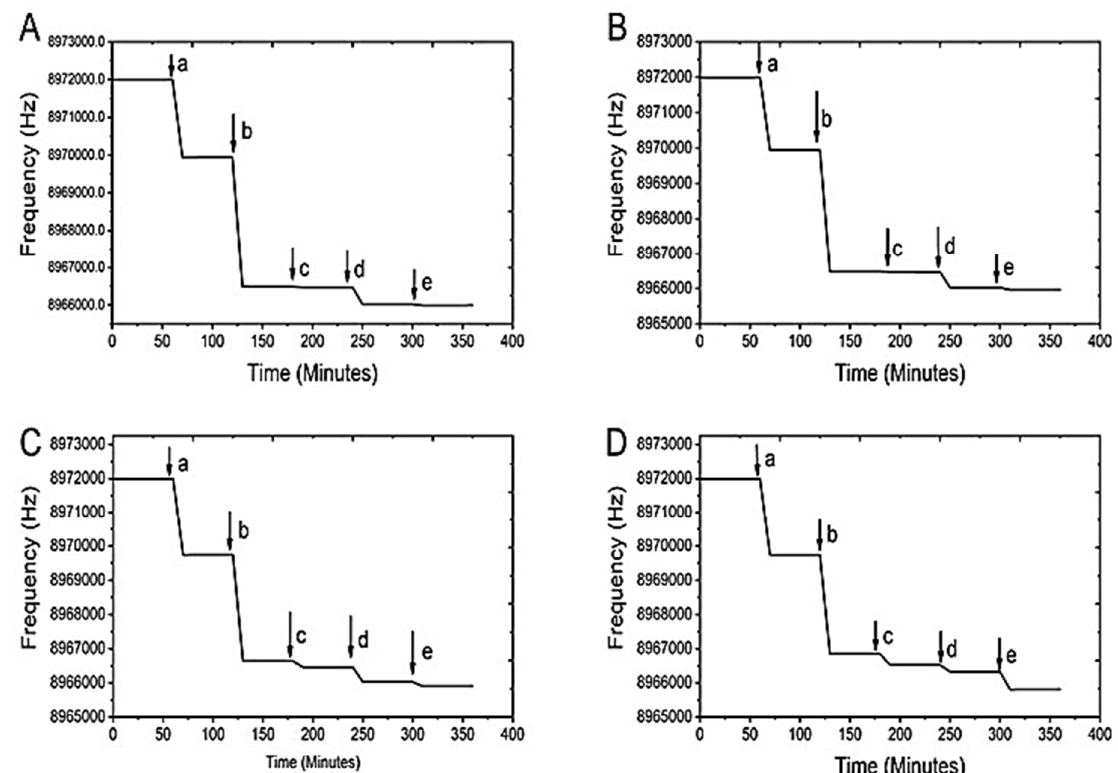
Figure 4. Stepwise modifications of the crystal 4-NMBA. ( A ) Represents the experiment with an E. coli concentration of 1 × 10 3 CFU/mL, ( B ) 1 × 10 4 CFU/mL, ( C ) 1 × 10 5 CFU/mL, and ( D ) 1 × 10 6 CFU/mL. For each graph, (a) represents the addition of the linker molecule MUA, (b) is the activation of the carboxyl group by EDC/NHS, (c) is the addition of the ligand, (d) is the addition of glycine (remove unbound ligand), and (e) is the detection of the E. coli .